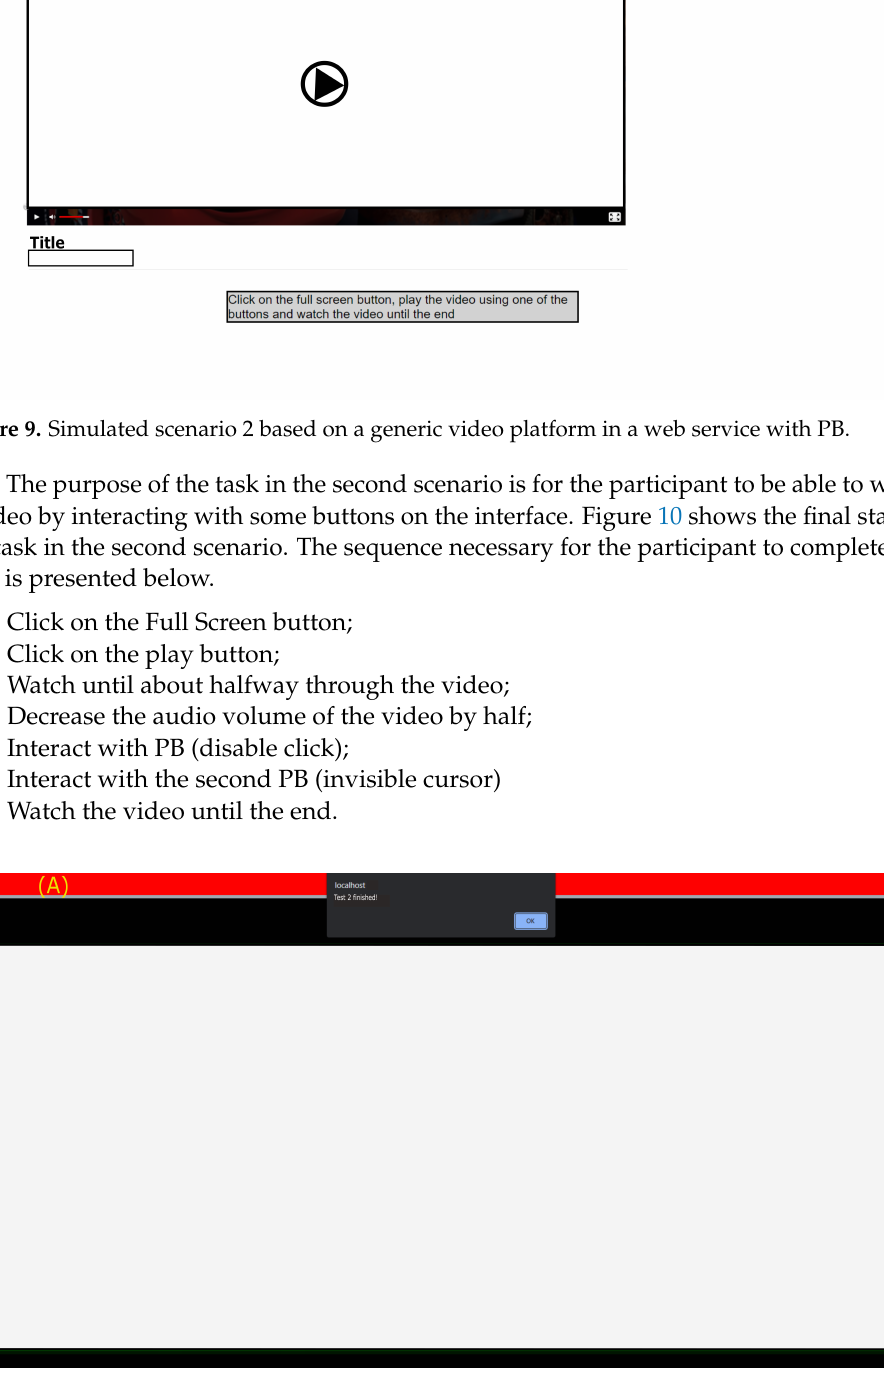
Figure 10. Final state of the task in scenario 2 in A secondary